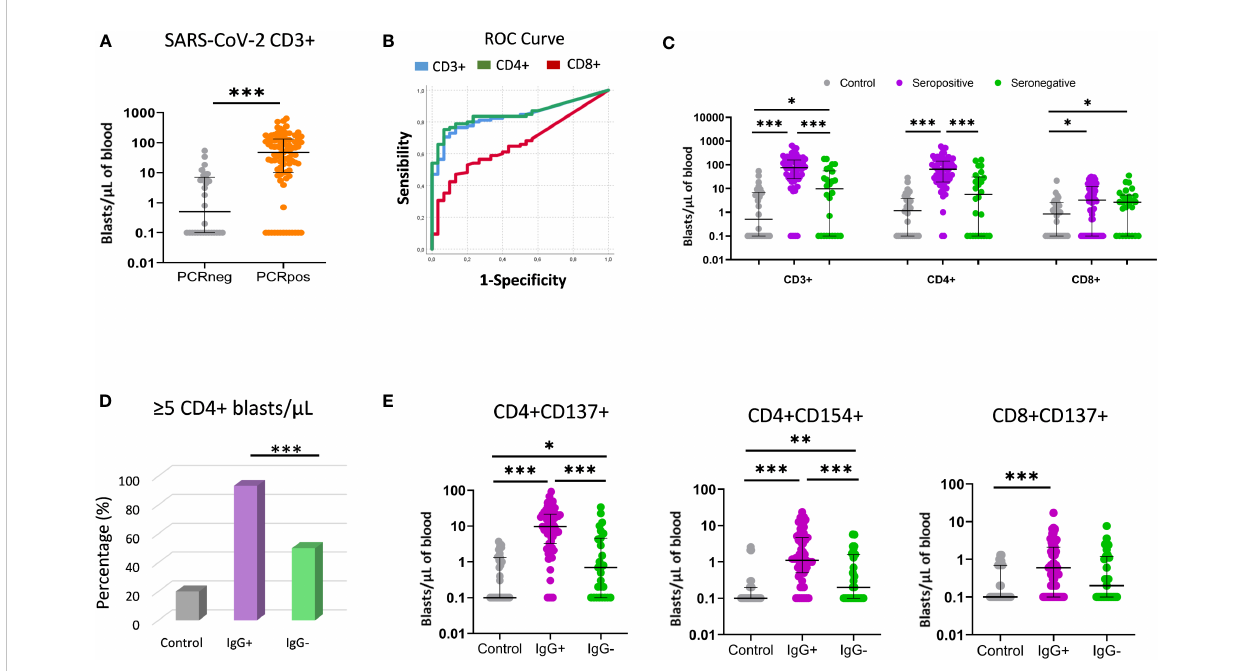
FIGURE 3 T-cell proliferative response using the FASCIA assay after stimulation with SARS-CoV-2 peptides. (A) Comparison of T-cell proliferative response between past infection patients (PCRpos) (orange dots; n=85) and healthy controls (PCRneg) (grey dots; n=30). Proliferating cells (blasts) are shown on a Forward Scatter (FSC) versus Side Scatter (SSC) dot plot. Median and IQR are shown. The Mann – Whitney test was used. (B) ROC curve analysis of CD3+ (blue line), CD4+ (green line) and CD8+ (red line) proliferative response to distinguish COVID-19 convalescent patients from healthy controls. (C) Comparison of CD3+, CD4+ and CD8+ response (blasts/µl) between healthy controls (grey dots; n=30), seropositive patients (purple dots; n=59) and seronegative patients (green dots; n=26). Median and IQR are shown. The Mann – Whitney U test was used. (D) Percentage (%) of